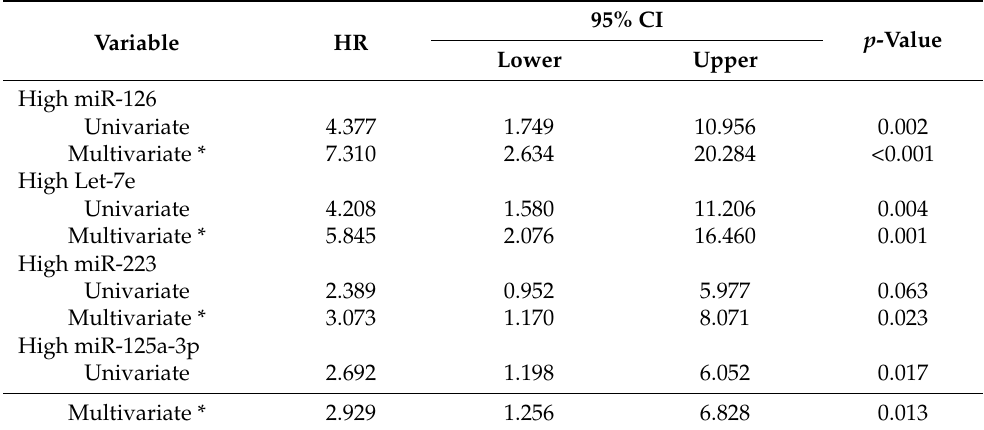
Table 3. Univariate and multivariate Cox regression model for prediction of long-term all-cause of mortality for miR-126, Let-7e, miR-223 and miR-125a-3p.